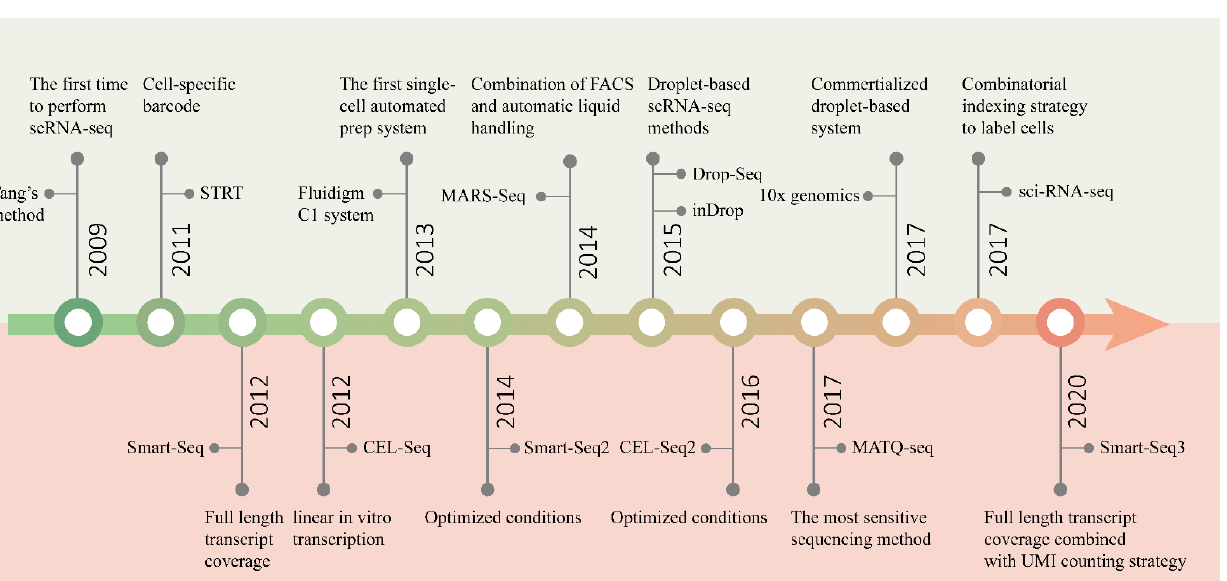
Figure 1. General workflow of scRNA-seq. Firstly, single-cell suspensions are obtained from cul- tured cells or tissue blocks. Then, cells are isolated and lysed. The released RNAs are reverse-tran- scribed into cDNAs. After second-strand synthesis and amplification, sequencing adapters are added to both ends of the cDNAs to construct the final sequencing library. Finally, bioinformatics